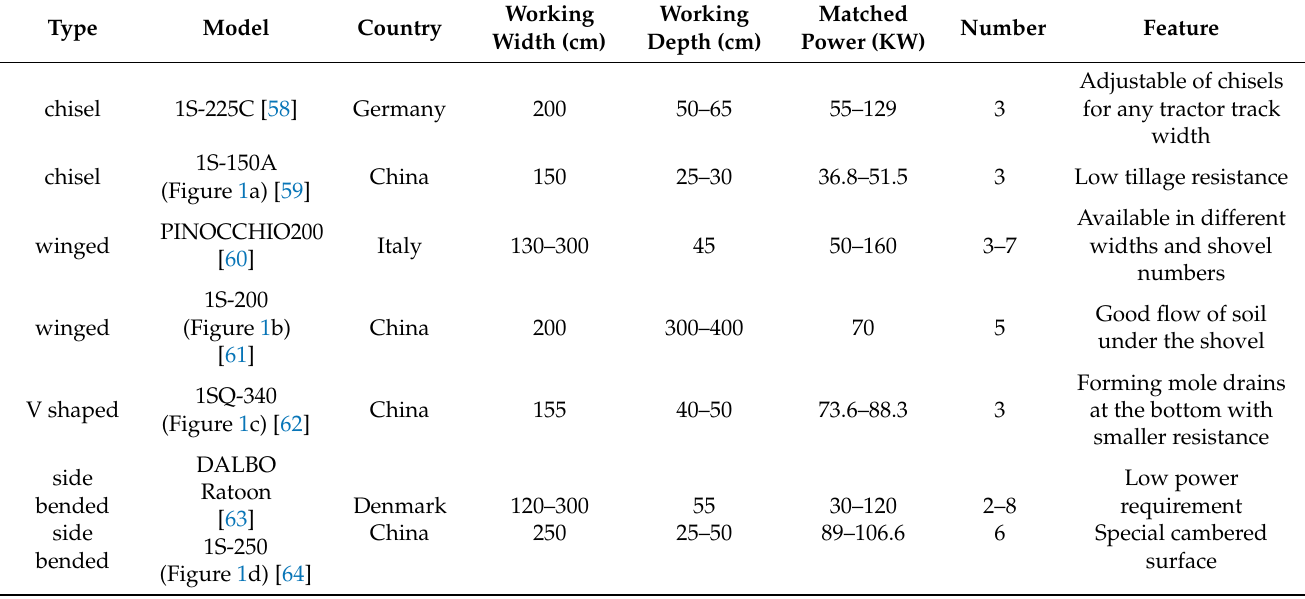
Table 3. Subsoiling shovel type, model, country, working width, working depth, matched power, number, and feature.